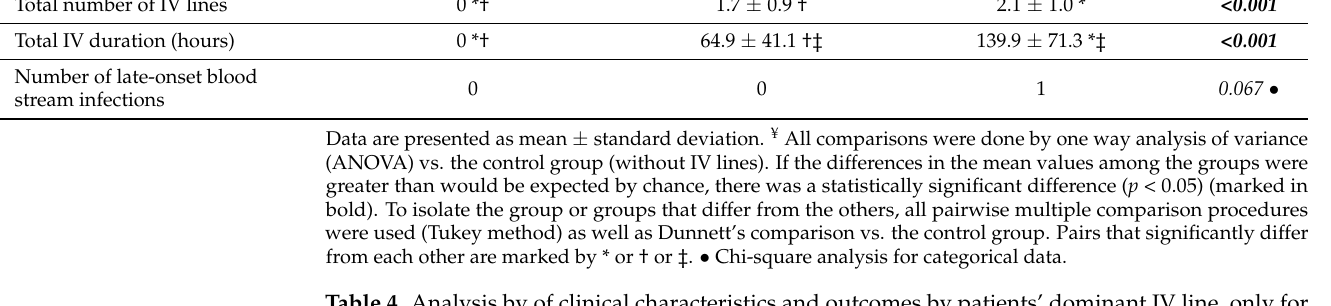
Table 4. Analysis by of clinical characteristics and outcomes by patients’ dominant IV line, only for those infants who had IV lines ( n =